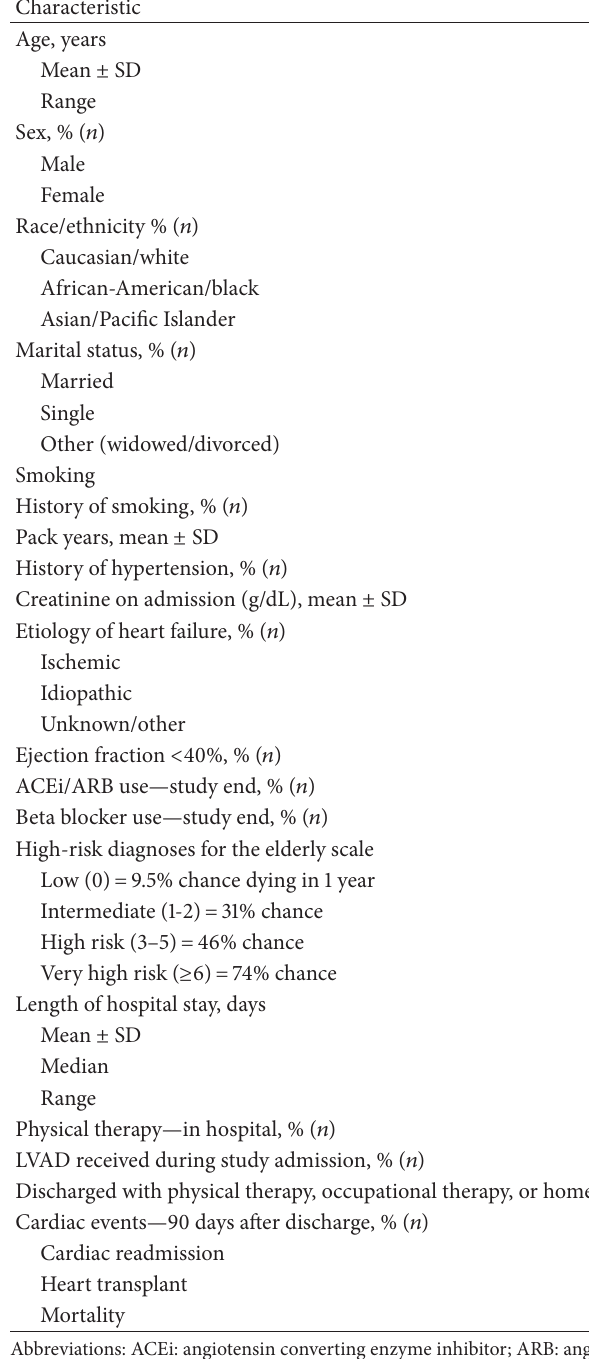
Table 3: Sociodemographic and clinical characteristics of study patients ( 𝑁 = 32